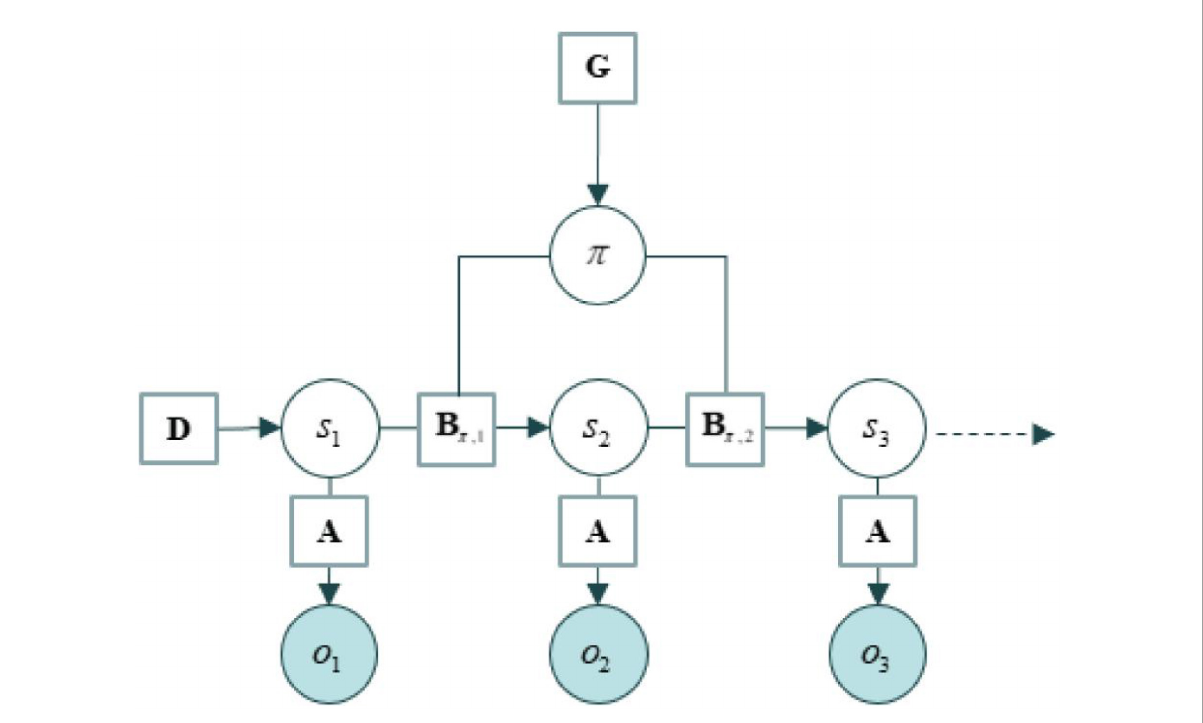
FIGURE1 An example of generative model taken from Albarracin et al. (2021).